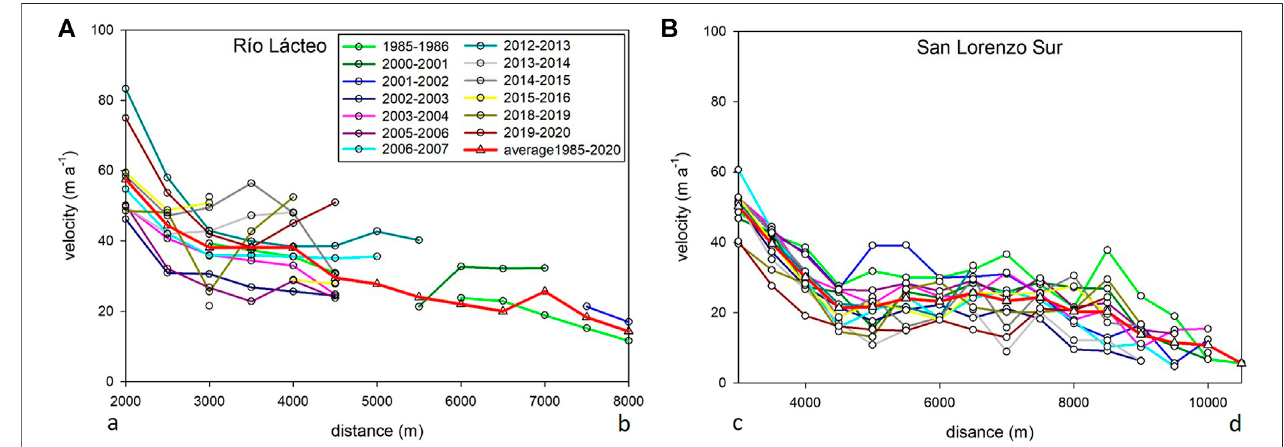
FIGURE 5 | Glacier fl ow velocities for longitudinal pro fi les on Río Lácteo (A) and San Lorenzo Sur (B) .